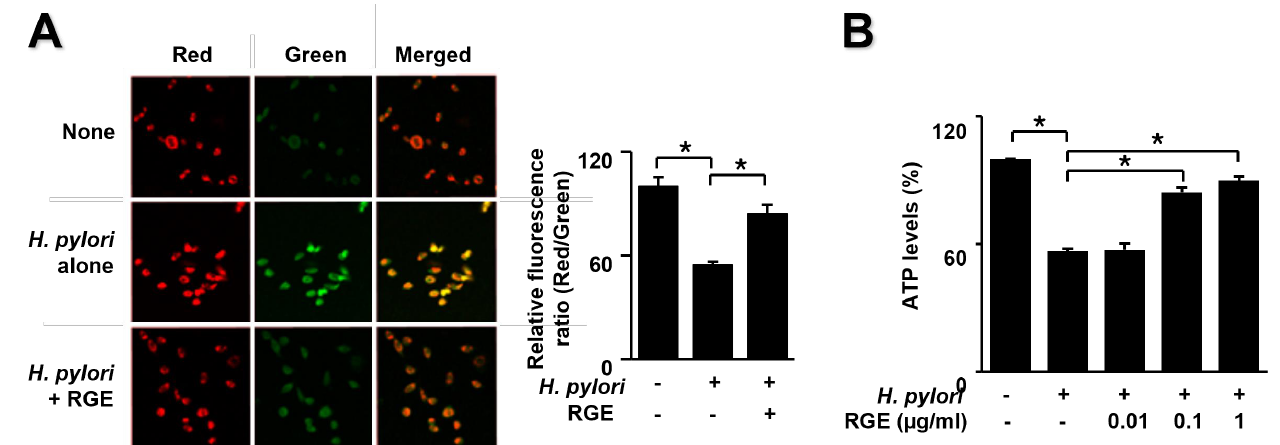
Figure 4. RGE suppresses mitochondrial dysfunction in H. pylori -stimulated AGS cells. The cells were pretreated with the indicated concentrations of RGE for 1 h and then infected with H. pylori for 1 h. ( A ) Mitochondrial membrane potential was assessed by staining JC-1 dye and red/green fluorescence images (left panel) and the ratio of red/green fluorescence (right panel). None, the untreated and uninfected cells; H. pylori alone, the untreated and H. pylori -infected cells; H. pylori + RGE, the RGE (1 µ g/mL)-treated and H. pylori -infected cells. ( B ) ATP levels were assessed using an ATP assay kit. ATP level in the untreated and uninfected cells was set at 100%. * p < 0.05. A membrane potential-sensitive color shift occurs by forming red fluorescent